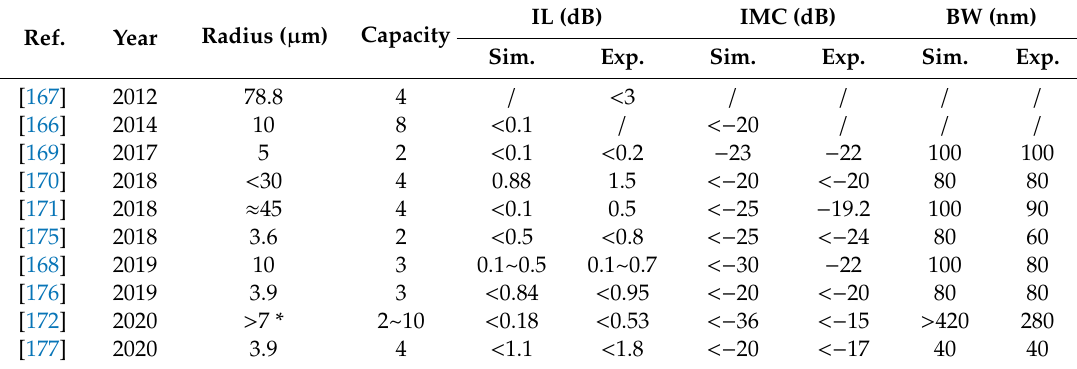
Table 5. Summary of the reported silicon multi-mode